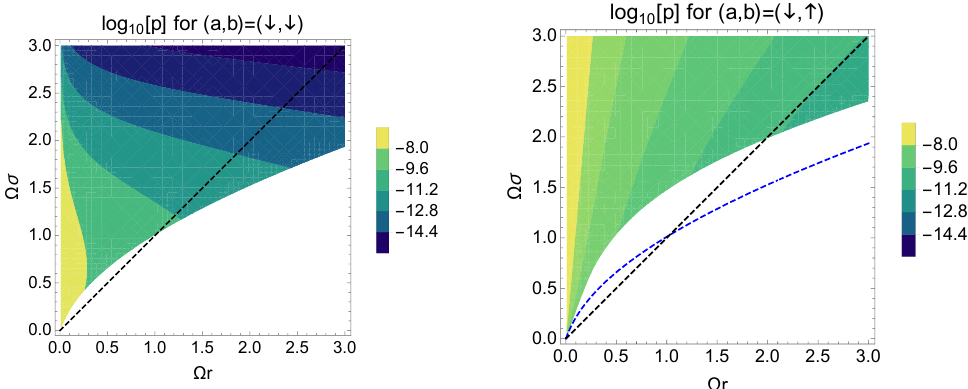
Figure 9. ( left ): The contour plot of the success probability p in common logarithms scale for the initial condition | ↓ A ↓ B (cid:105) . The colored region denotes that β is larger than unity in the parameter space ( Ω r , Ω σ ) . As the distance or the interaction time increase, the probability becomes small. ( right ): The contour plot of the success probability p in common logarithms scale with β > 1 for the initial condition | ↓ A ↑ B (cid:105) . The blue dotted curve represents the curve β = 1 for the initial condition |↓ ↓ (cid:105) equals to unity. The detection region of the violation of the Bell-CHSH inequality is reduced, A B but its probability increases from the case for the initial condition |↓ A ↓ B (cid:105)